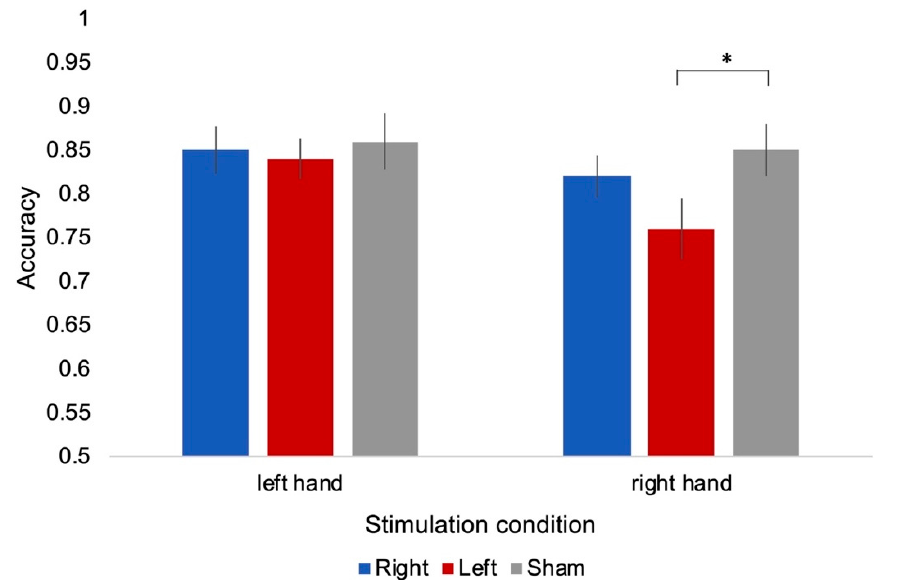
Figure 4. Mean accuracy (bars are standard error of measurement, SEM) as a function of stimulation condition (right, left, and sham) and laterality of hand stimuli. * Bonferroni post-hoc comparisons, significant at p = 0.045.